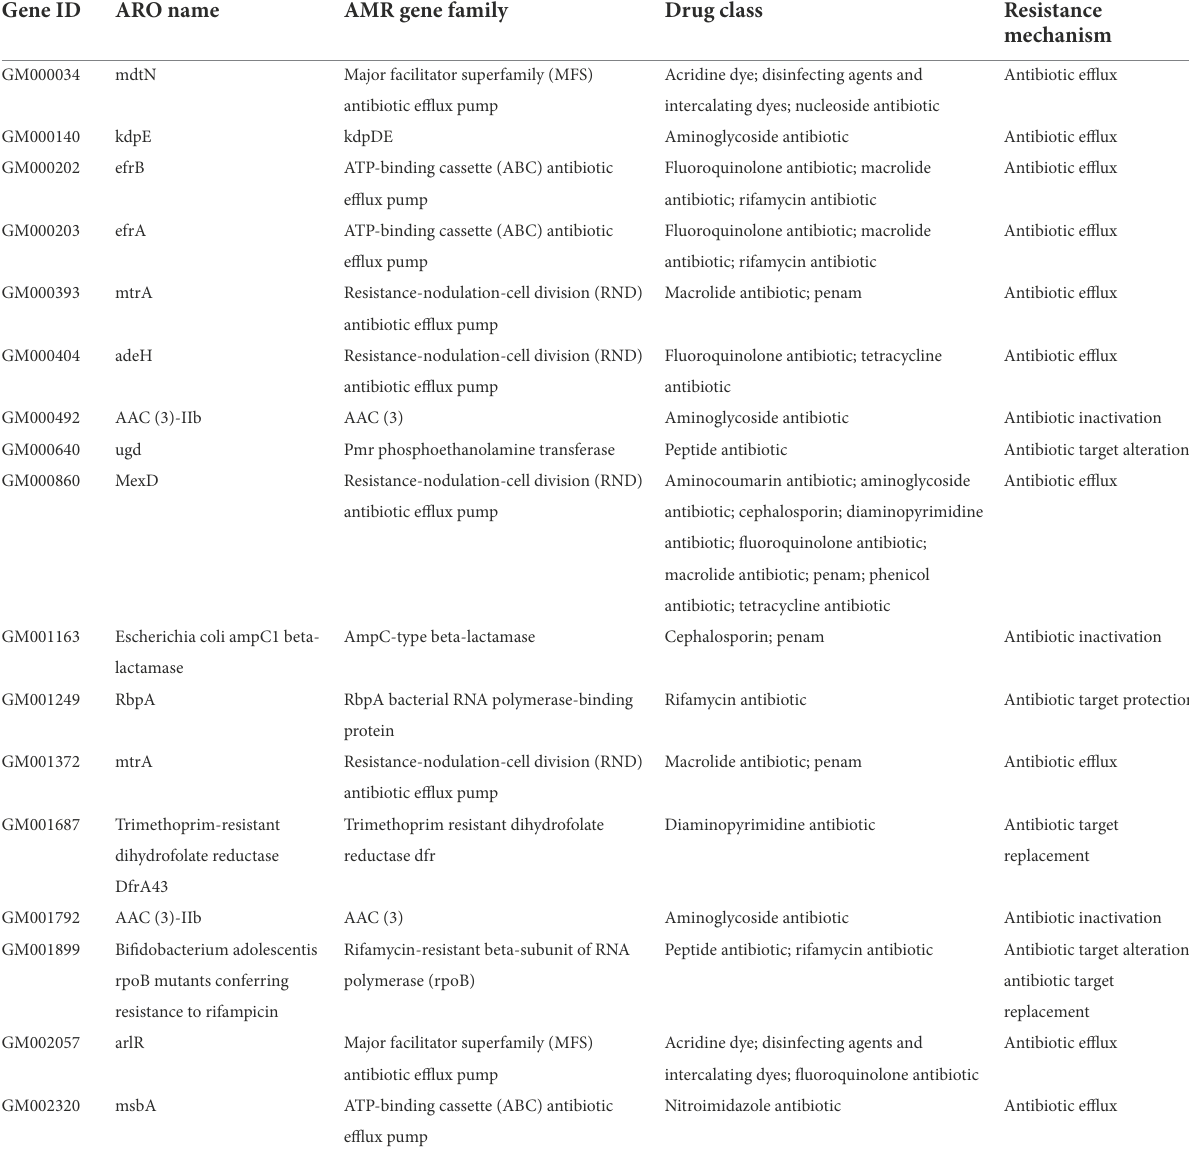
TABLE 1 Annotation of bacterial antibiotic-resistance genes of Pacne11-13.